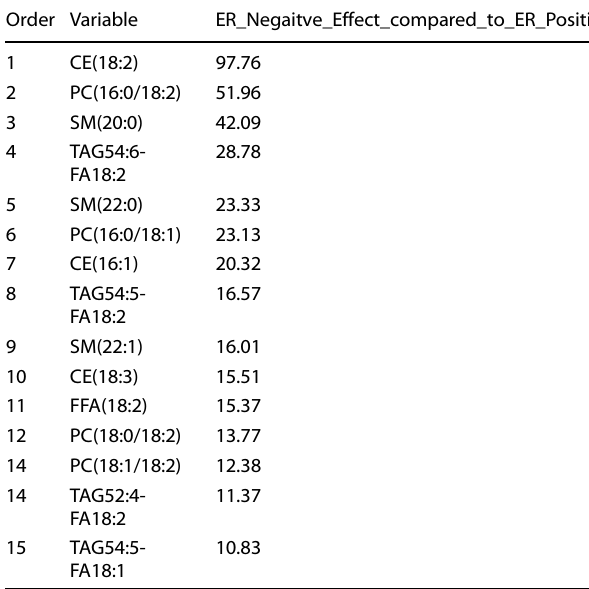
Abbreviations: CE cholesterol ester, FFA free fatty acids, PC phosphatidyl- choline, SM sphingomyelin, TAG triacylglycerol. TAGs have 3 acyl chains, but it is only possible to measure the length and number of double bonds of 1 of them. For example, TAG54:6-FA18:2 has 1 chain that is an 18:2 FA and the other two have a total of 54 carbons and 6 double bonds. The whole TAG has 72 carbons in the chain (plus 3 from the glycerol backbone) and a total of 8 double